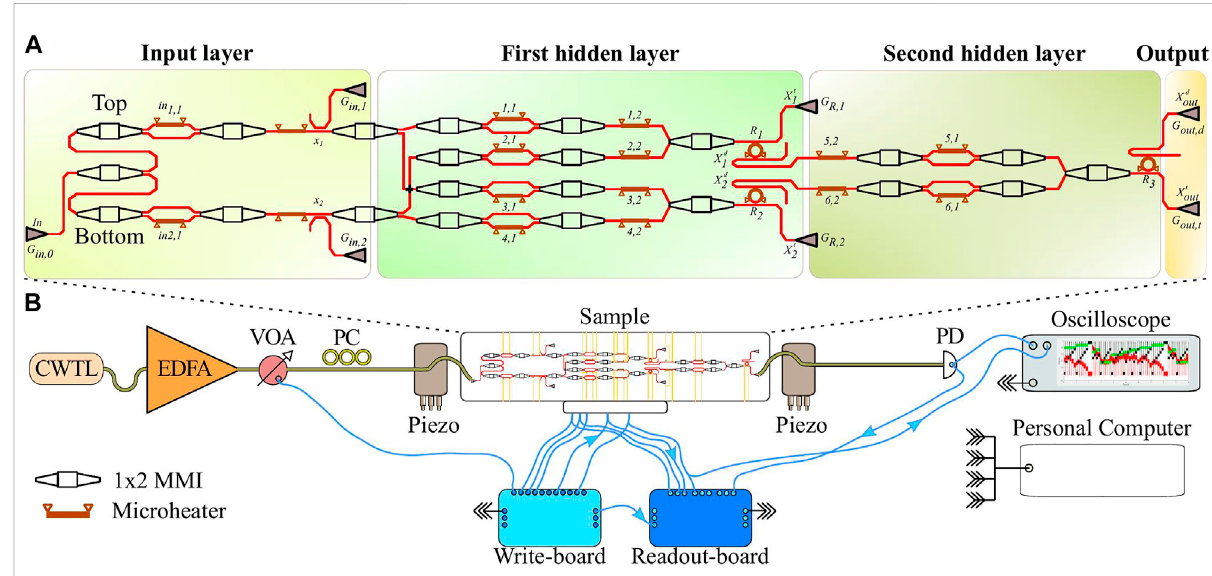
FIGURE 6 (A) Design of the feed-forward neural network. It consists of four parts: an input layer where the information is encoded, a fi rst/second hidden layer where the input data is processed, and fi nally, an output layer to record the network ’ s response. The red lines show the silicon waveguides, the brownonestheintegratedheaters,whiletheblackcomponentsthebalanced1×2or2×1Multi-ModeInterferometers(MMIs).Thethreenon-linear microresonators play the role of the active nodes. Labels and numbers on the design are explained in the text. (B) Sketch of the experimental setup. CWTL: Continuous Wave Tunable Laser, EDFA: Erbium Doped Fiber Ampli fi er, VOA: Variable Optical Attenuator, PC: Polarization Control and PD: Photodiode. Details are explained in the